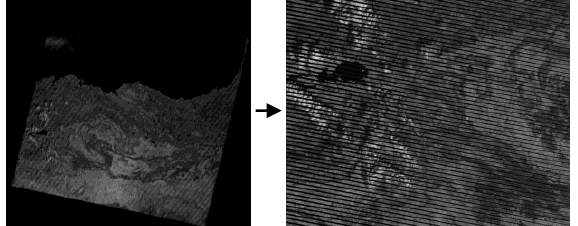
Figure 10. Example of striping in Landsat 7 ETM+ Level-1 Band 5 data.